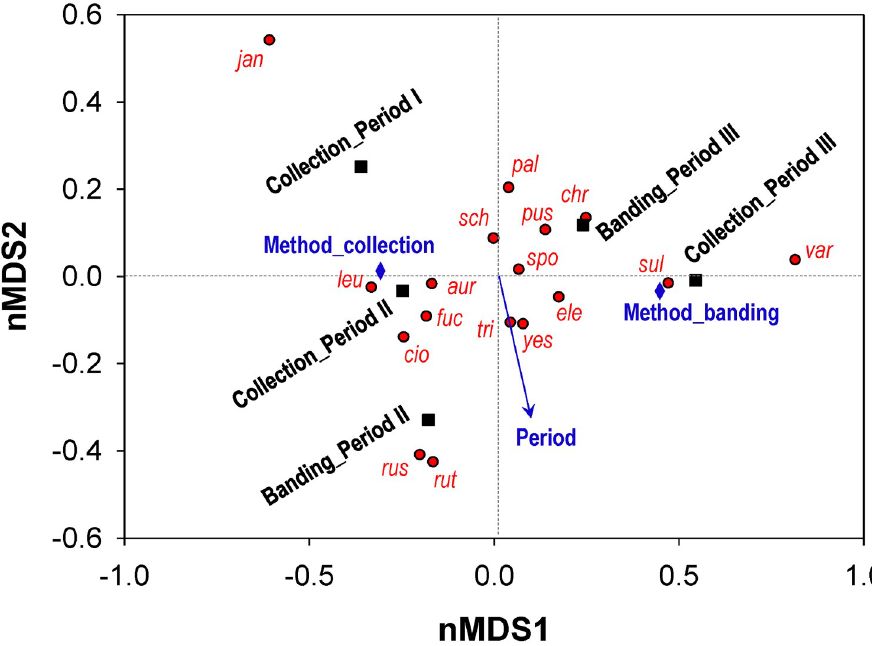
Fig 2. Two-dimensional non-metric Multidimensional Scaling (nMDS) ordination of data samples. Species scores, group scores, and variables (methods and periods) from the nMDS ordination were plotted, and the patterns in bunting community composition were revealed based on the dissimilarities. Each Emberiza species was marked by the first three letters of its epithet in a lower case.